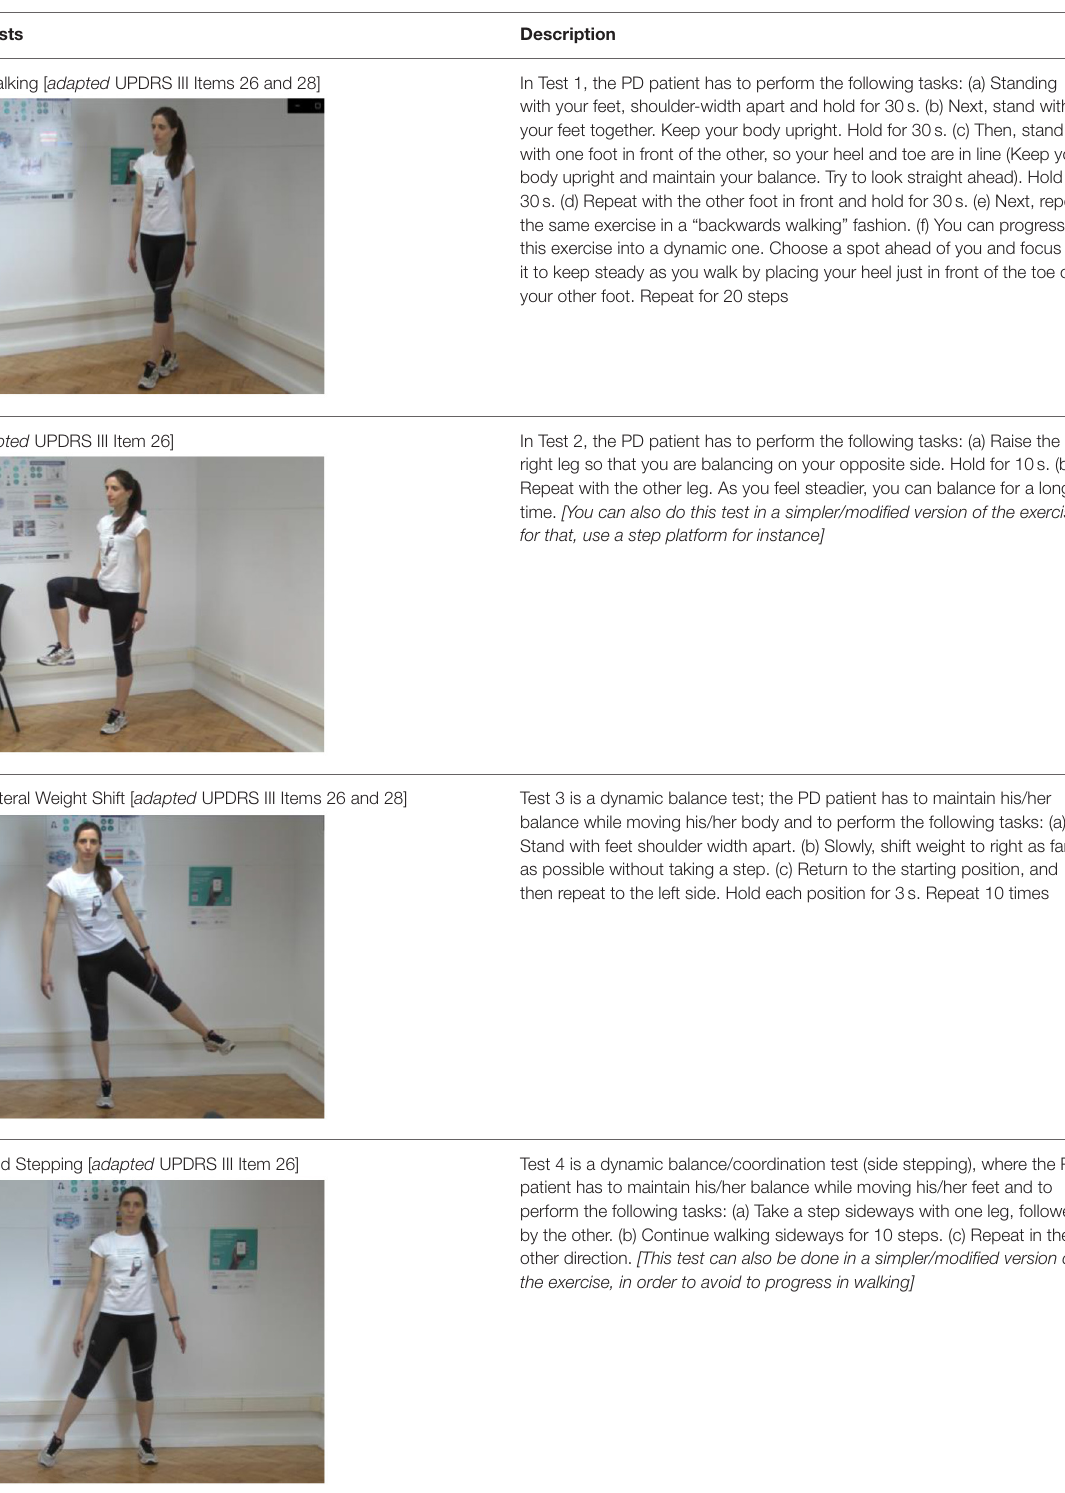
TABLE 1 | Description of the Assessment Tests (Test 1–Test 6) of the iPrognosis Games based on the UPDRS Part III motor